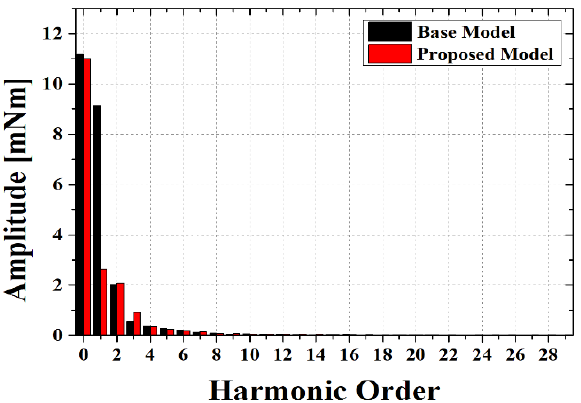
Figure 20. FFT analysis of the torque waveforms of the base and proposed models.